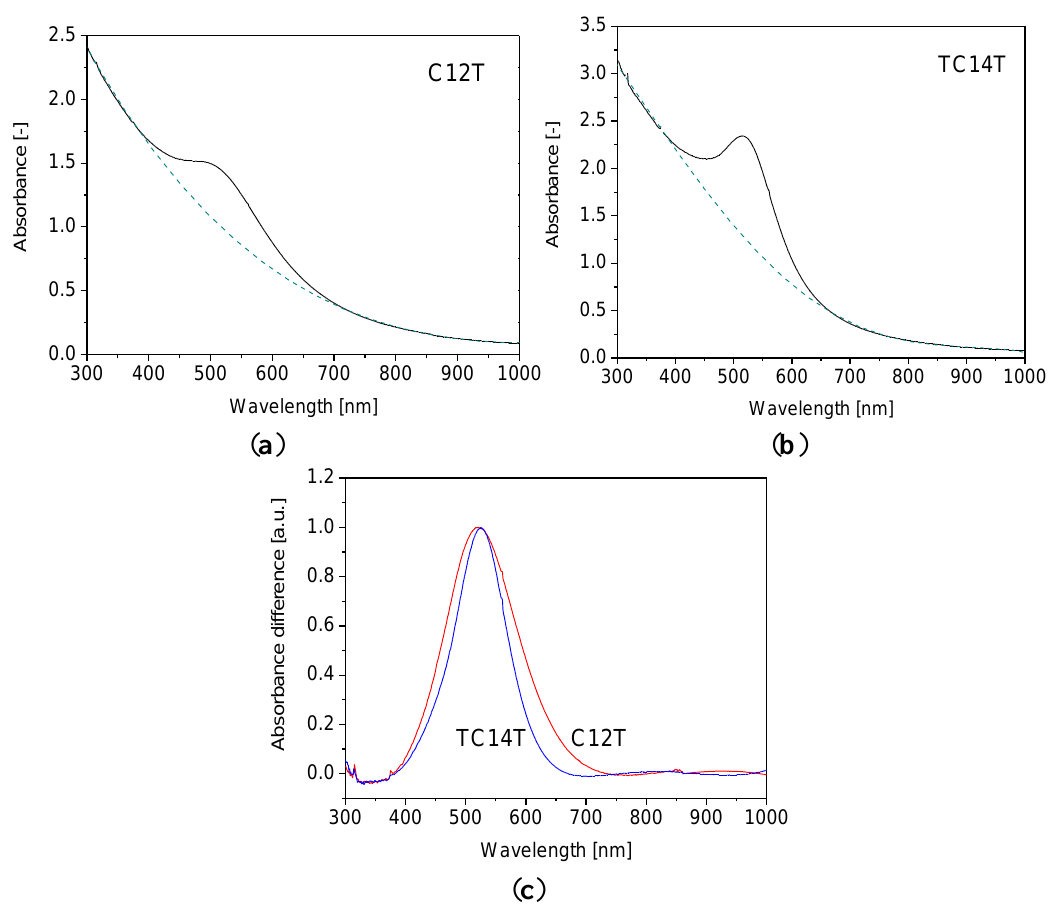
Figure 3. UV-vis spectra of gold nanoparticles coated ( a ) with 1-dodecanethiol (C12T) or ( b ) tert -tetradecanethiol (TC14T); dispersed in toluene (concentration ca . 0.2 mg/mL). The dashed line represents the absorbance of an arbitrarily fitted background on the basis of a 4th order polynomial; ( c ) absorbance of the alkanethiol-coated particles after subtraction of the 4th order background, normalized to 1 to the peak maximum.